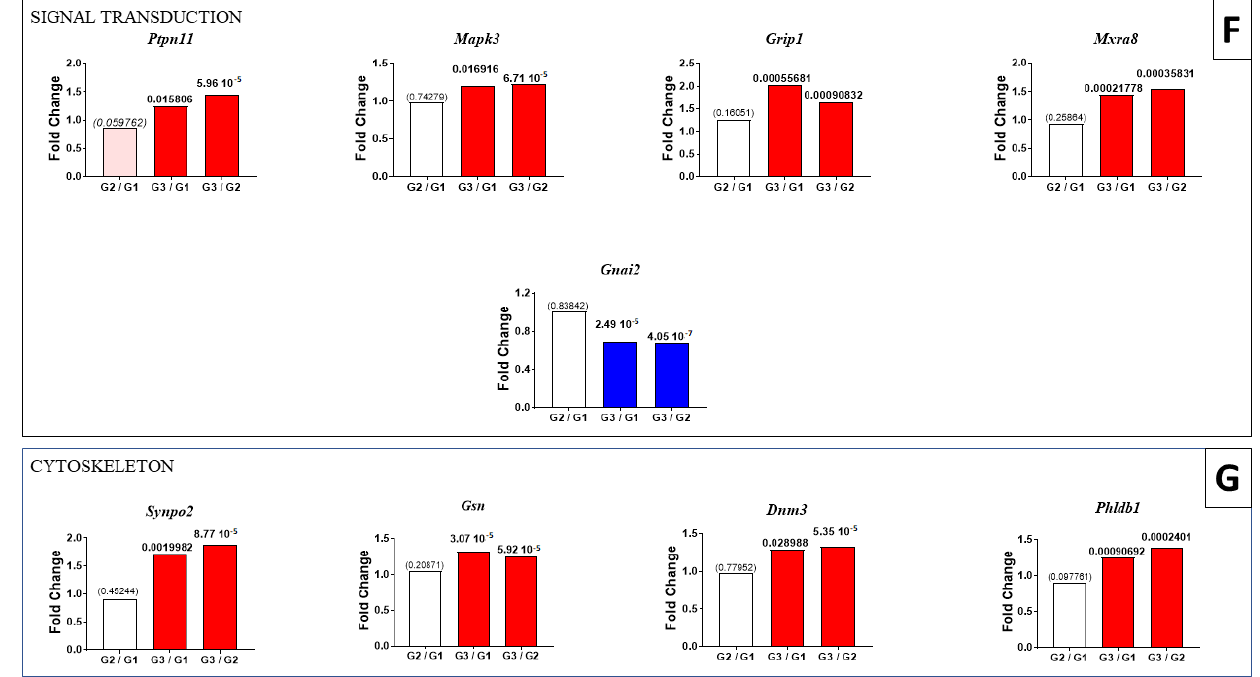
Figure 5. Specific abundance changes related to multiple early curcumin treatments. ( A ): proteins involved in tumor microenvironment. ( B ): proteins involved in intracellular trafficking. ( C ): cell metabolism enzymes. ( D ): proteins involved in cell-cell interactions. ( E ): proteins involved in apoptosis regulation. ( F ): proteins involved in signal transduction. ( G ): cytoskeletal proteins. The results are shown for a selection of proteins based on the most significant p values observed in the comparison of G3/G1 and G3/G2 (indicated in bold at the top of the bars). Proteins are identified by their encoding genes ( in italics ). For nonsignificant differences observed in the comparison of G2/G1, p values are indicated in brackets and for tendencies in italics (in brackets).